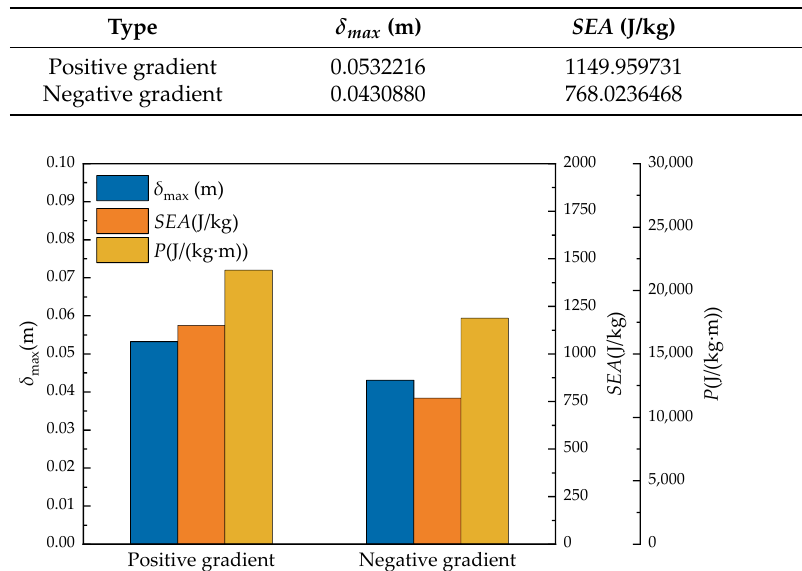
Table 7. The indices of two gradients.